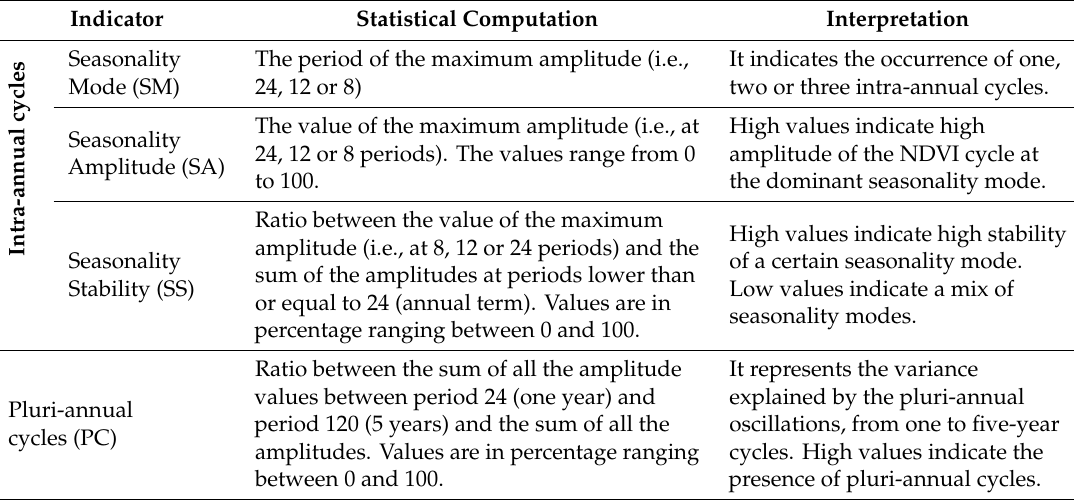
Table 1. Periodicity indicators for NDVI time